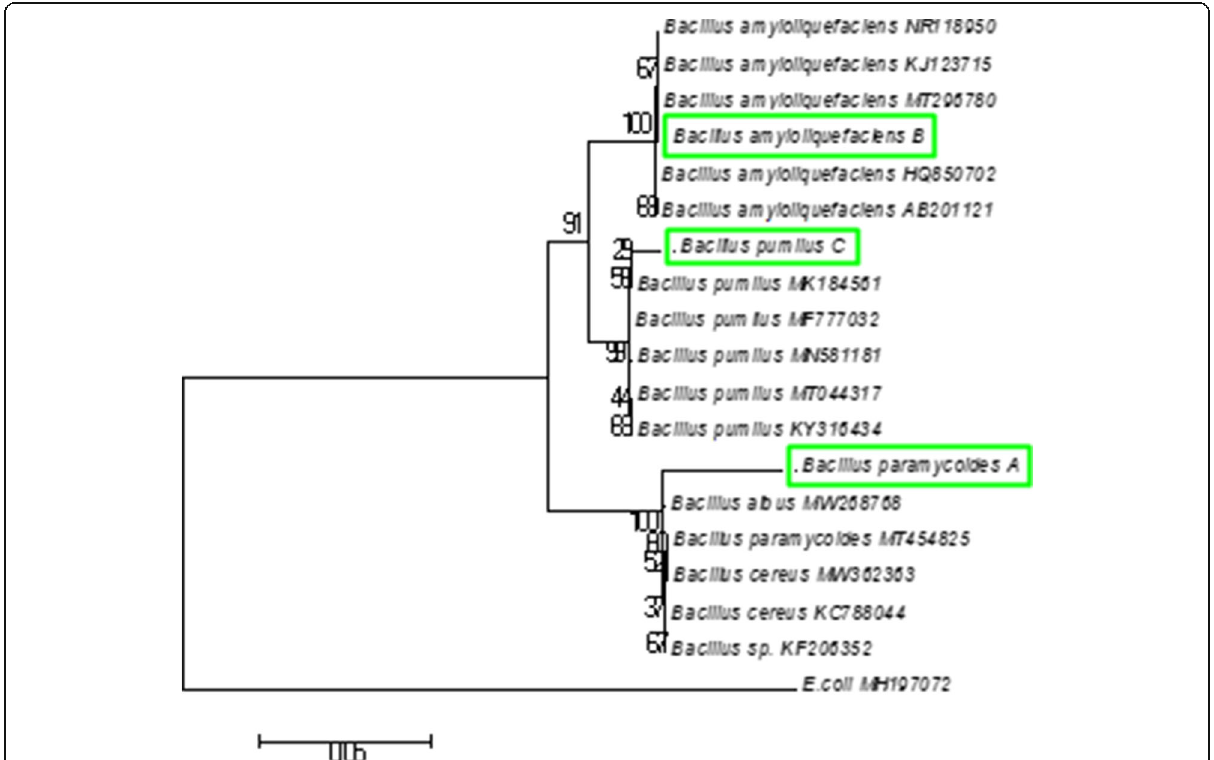
Fig. 4 Phylogenetic tree constructed by the neighbor-joining method derived from analysis of the 16S rRNA gene sequence of salt-tolerant PGPR bacterial isolates and related sequences obtained from NCBI. Scale bar, 0.05 substitutions per nucleotide position. Bacillus paramycoides A (HB6J2), Bacillus amylofaciens B (HB8P1) and Bacillus pumilus C